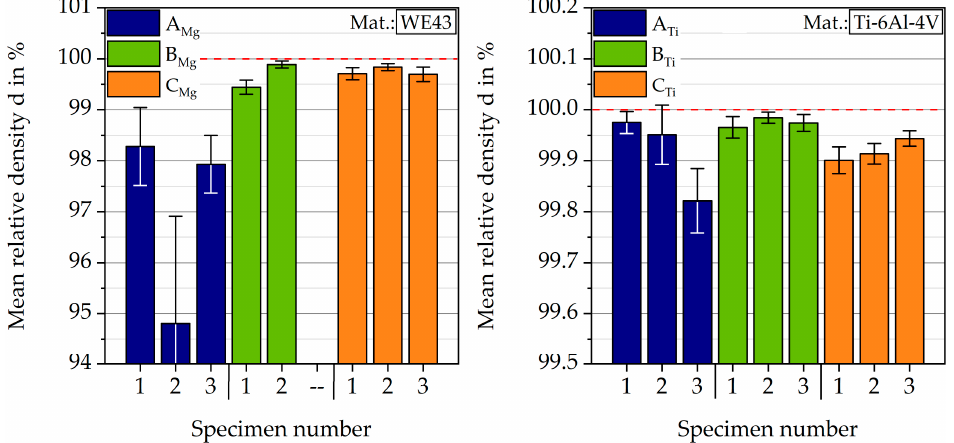
Figure 7. Mean relative densities of magnesium and titanium specimens.